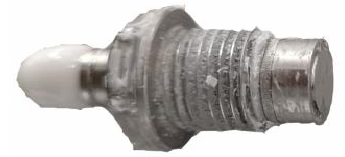
Figure 6. Pressure sensor.